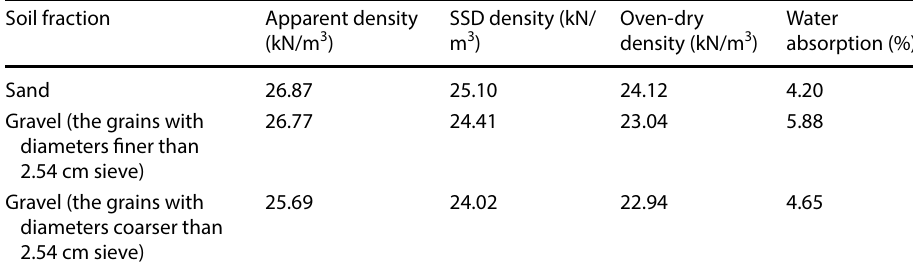
Table 2 The apparent density, bulk density, SSD state density and water absorption of native soil aggregates (in accordance with ASTM C127 [33] and ASTM C128